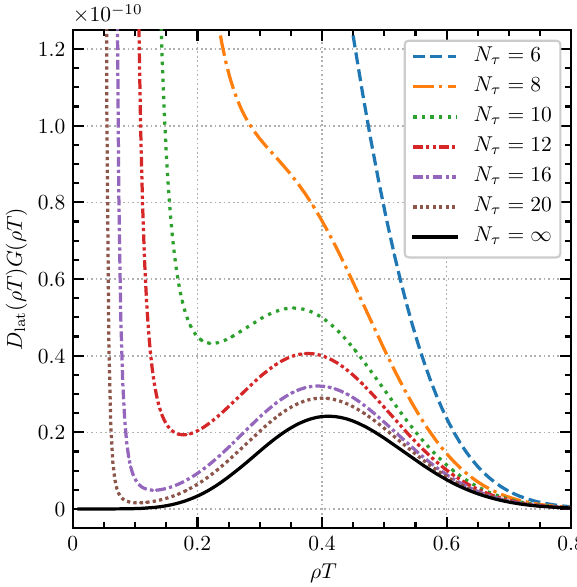
Fig. 3 Topologicalcharge Q imp asafunctionofflowtimeforacaloron with ρ T = 0 . 5, for three flow definitions and two box sizes ( N τ = 8 is fixed). Calorons Live much longer under Zeuthen flow, and forever under overimproved flow